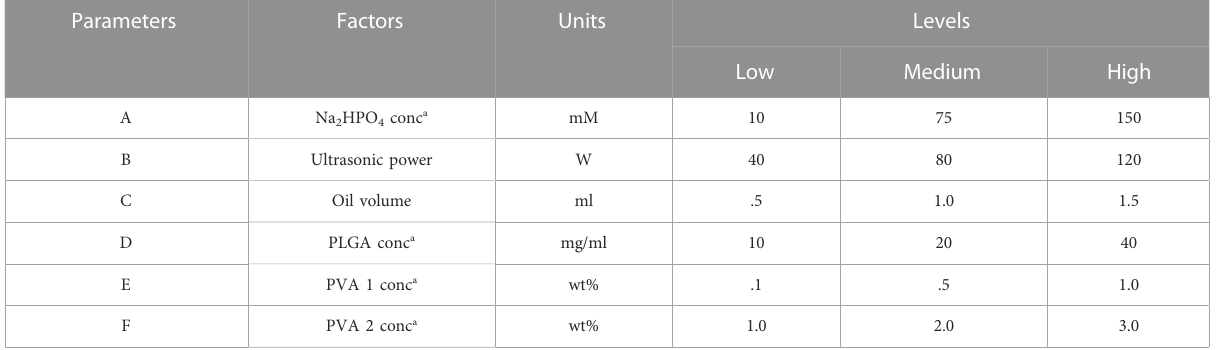
TABLE 1 Variables (factors) along with their corresponding levels in the orthogonal experiment design for fabrication of PLGA nanorods by two-step ESE method.